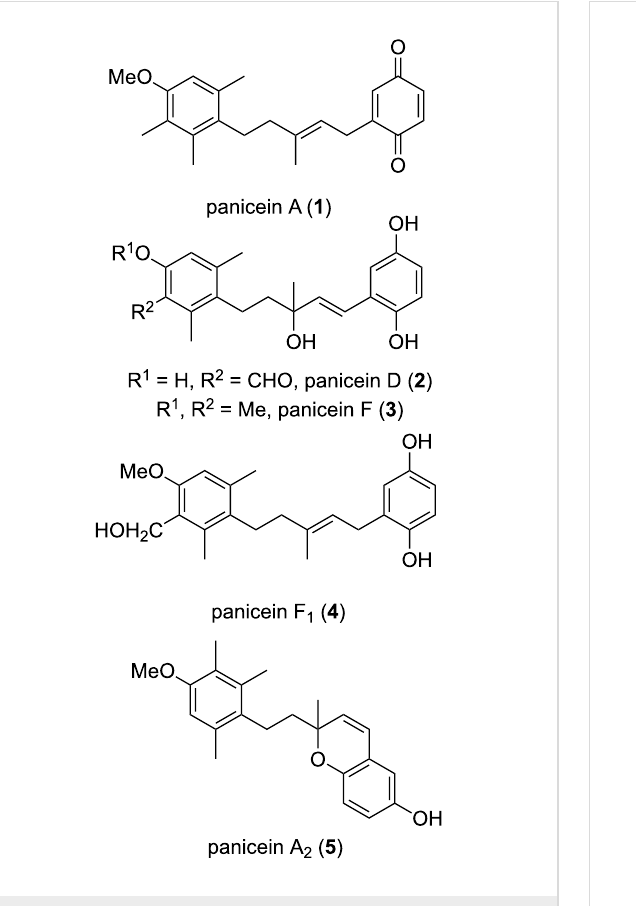
Figure 1: Members of the panicein family of aromatic sesquiter- penoids. Figure 2: Proposed biogenesis of panicein A 2 ( 5 ).